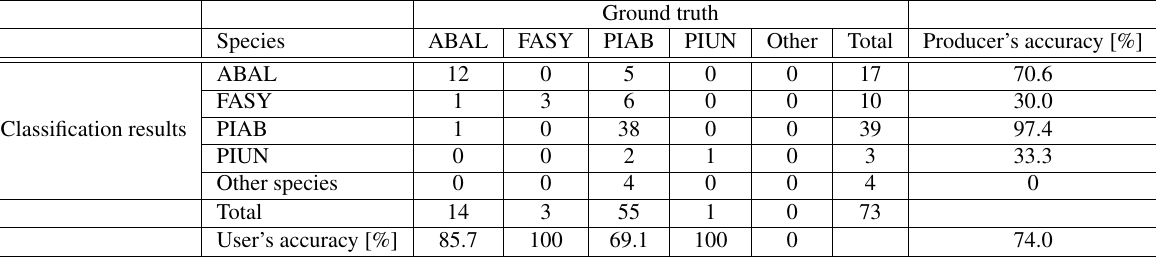
Table 8: Species classification results at tree-level obtained by the fusion of HI and LiDAR features